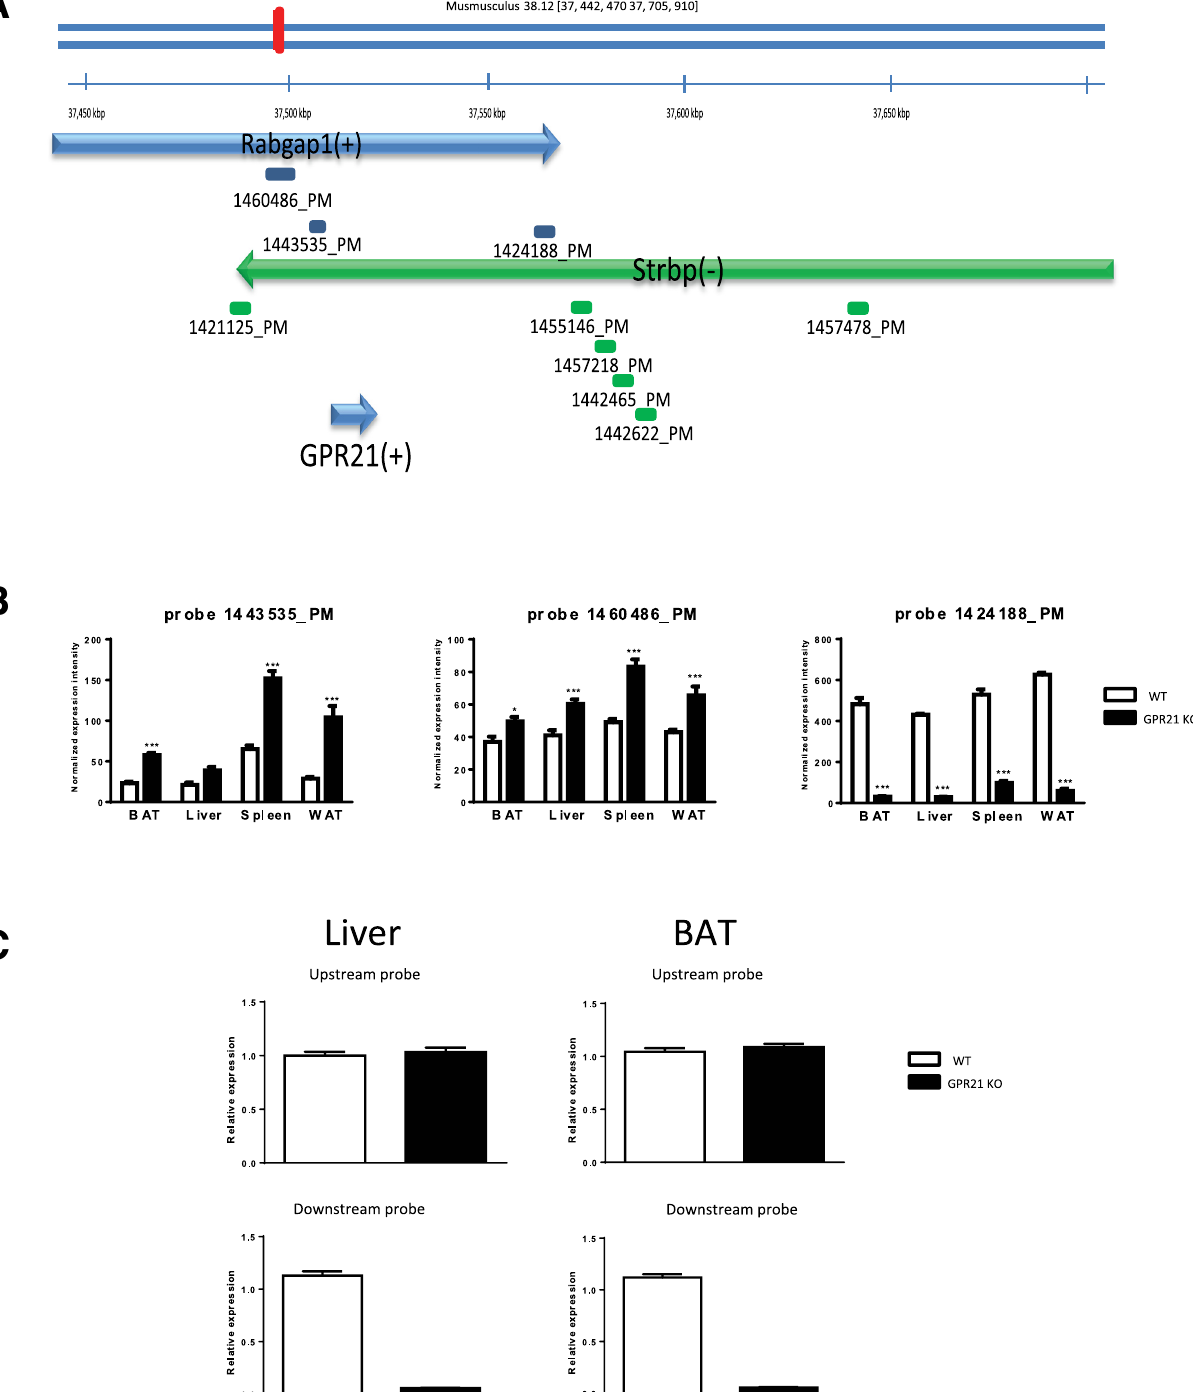
Figure 1. ( A ) Mouse Gpr21 is located on Chromosome 2 within the intron of Rabgap1 gene between exon 13 and 14 on the positive strand according to UCSC GRCm38/mm10 assembly. Strpb gene is on the opposite strand in the same region. The blue arrow represents the positive strand while the green one the negative strand. The bars under the genes represent microarray probe sets from Affymetrix mouse array HT MG-430PM platform. There is no probe set covering Gpr21 gene. The closest probe set 1421125_PM is located at 2,866 bases upstream of Gpr21 . ( B ) The level of Rabgap1 transcript was shown as normalized expression intensity. RNA was prepared from BAT, liver, spleen and WAT of Deltagen Gpr21 KO mice and their WT littermate controls. Probe 1443535_PM, 1460486_PM and 1424188_PM allow detection of Rabgap1 mRNA expression levels. ( C ) Rabgap1 mRNA expression levels were assessed using 2 Taqman probes in liver (left panel) and BAT (right panel) of GPR21 KO and their wildtype littermate